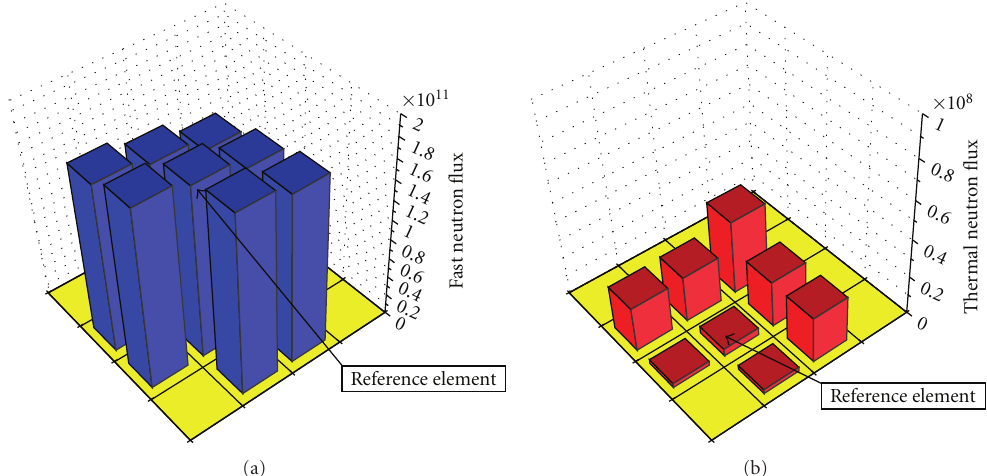
Figure 6: Fast neutron flux (a) and thermal neutron flux, (b) in the di ff erent relevant fuel elements in the fast part of YALINA-Booster for